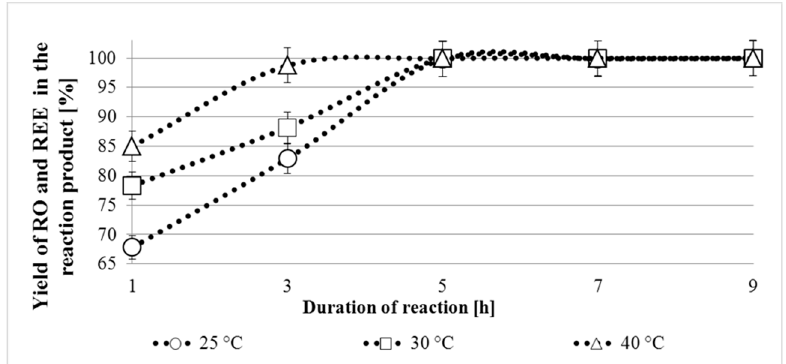
Figure 1. The dependence of the yield of rapeseed oil (RO) and rapeseed ethyl esters (REEs) on the reaction time and temperature when the mineral diesel and rapeseed oil blend ratio was 9:1 (w/w), the oil-to-ethanol molar ratio was 1:5 and the lipase (Lipozyme TL IM) concentration was 7%.